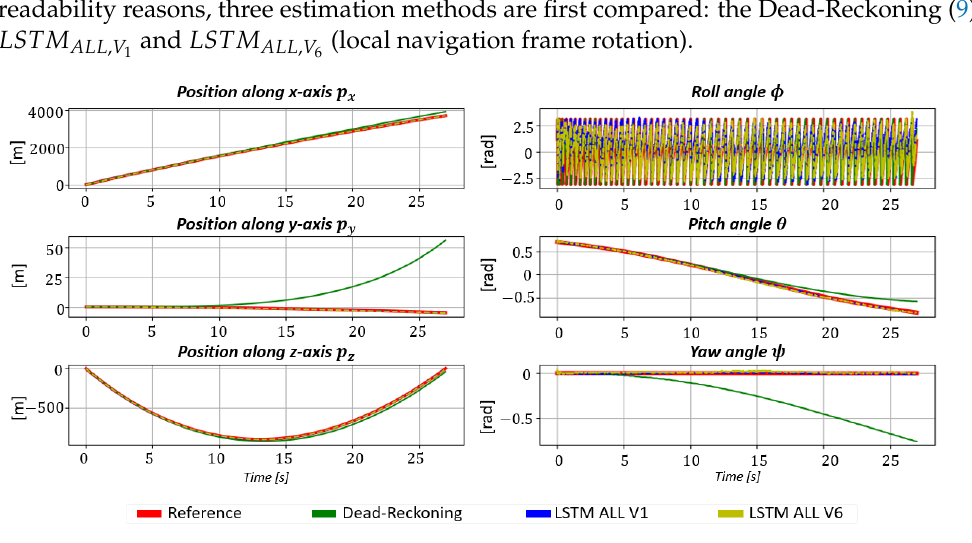
Table 2. Training characteristics of LSTM ALL , POS , VEL , ANG , V